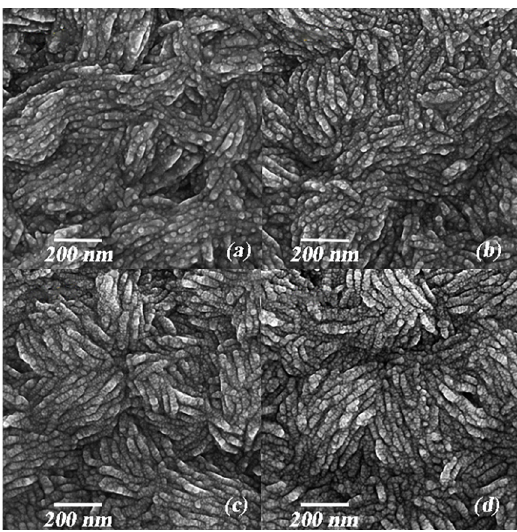
Figure 4. FESEM micrographs showing ZnO/Ag bilayer surfaces with different Ag thicknesses (a) 5 Å, (b) 10 Å, (c) 20 Å, (d) 30 Å